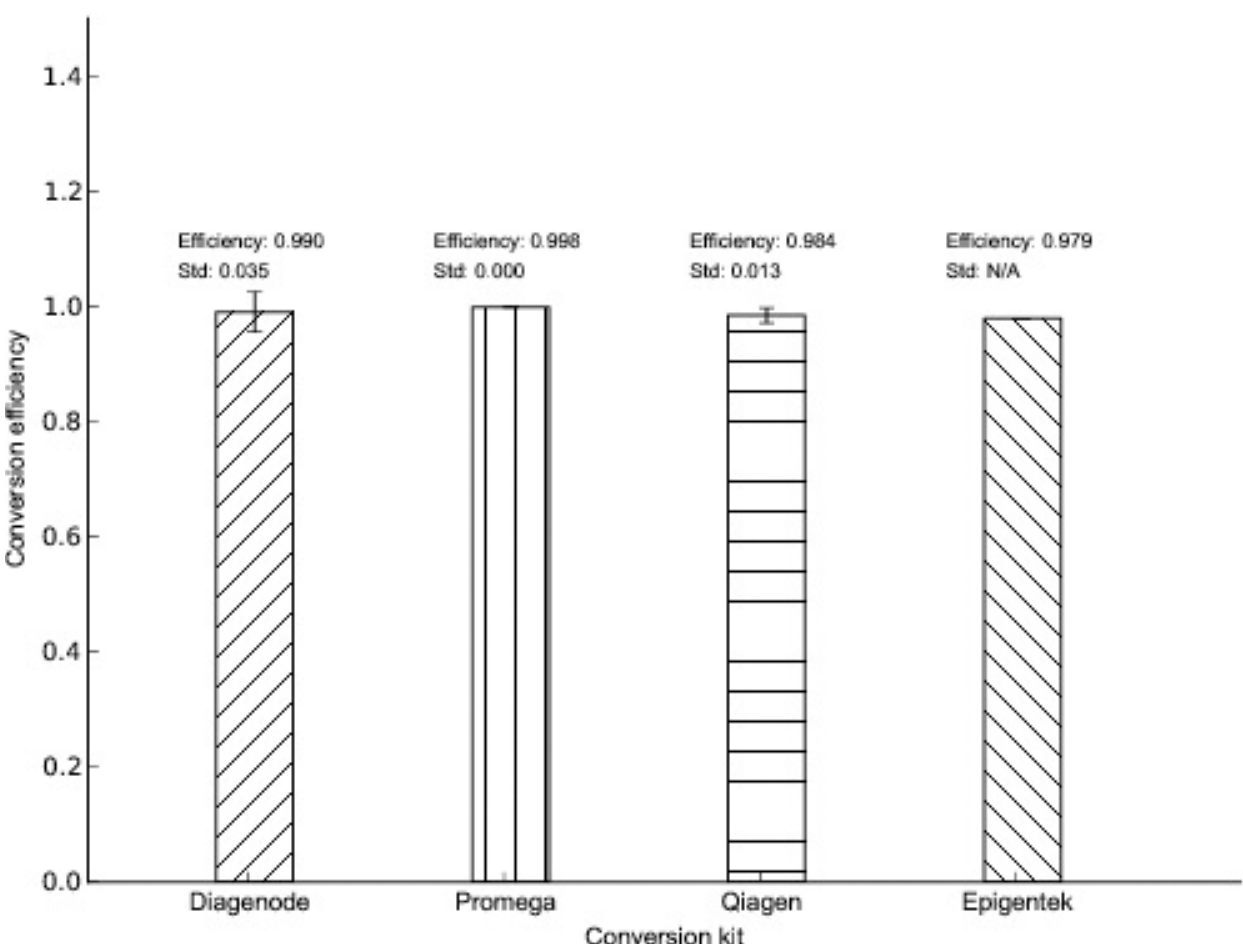
Fig 3. Bisulfite conversion efficiency of the different kits. The conversion efficiency of the unmethylated cytosines to thymines was calculated per kit. All the non-CpG cytosines of all the 24 libraries of the Lambda control 1 were used for the calculation. Conversion efficiency of the Premium Bisulfite kit (Diagenode) was 99.0 ± 0.035%, of the MethylEdge Bisulfite Conversion System (Promega) was 99.8 ± 0.000%, of the EpiTect Bisulfite kit (Qiagen) was 98.4 ± 0.013% and of the BisulFlash DNA Modification kit (Epigentek) was 97.9%. Error bars = SD.